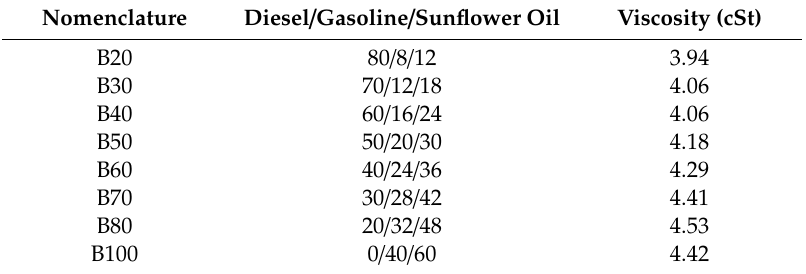
Table 3. Viscosity values of the triple blends, diesel / gasoline / sunflower oil, obtained by adding di ff erent amounts of fossil diesel to a double mixture of gasoline / sunflower oil, containing 40% gasoline.